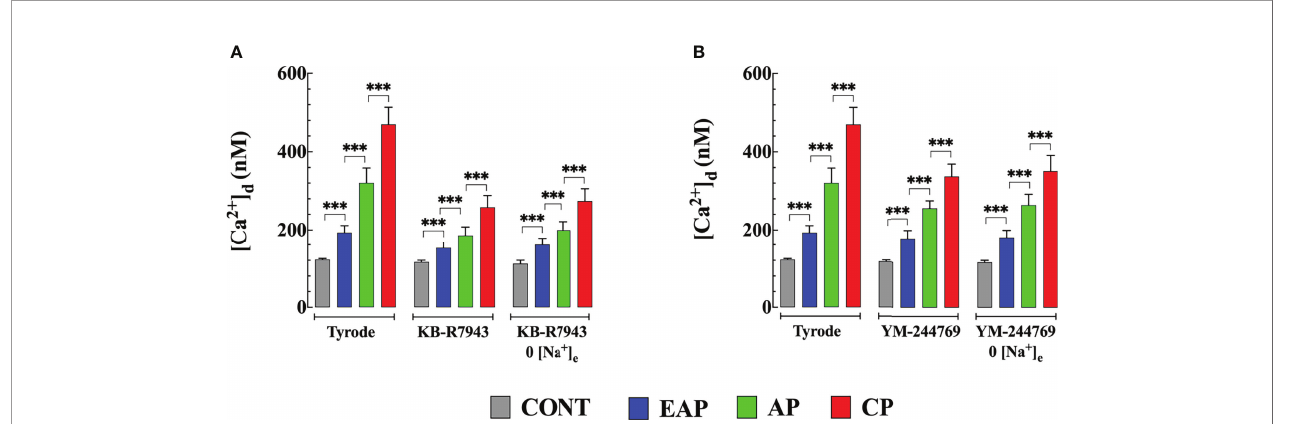
FIGURE 5 | NCX blockers inhibited Na + withdraw-induced [Ca 2+ ] d increases in cardiomyocytes from control and Chagas infected mice. (A) Effects of KB-R7943 and (B) YM-244769 on [Ca 2+ ] d increases caused by Na + removal. [Ca 2+ ] d was determined in (i) normal Tyrode solution (ii) after 10 min of incubation with 10 m m KB- R7943) or 1 µM YM-244769 and (iii) after incubation, either KB-R7943 in Na + free solution or YM-244769 in Na + free solution. Experiments were carried out in cardiomyocytes from CONT (n cells =15-24 and n mice =6), EAP (n cells =12-19 and n mice =8), AP (n cells =13-21 and n mice =8) and CP cardiomyocytes (n cells =11-18 and n mice =9). Data are expressed as mean ± S.E. Statistical analysis was performed as described above, ***p < 0.001. CONT: control mice; EAP: early acute phase of infected mice; AP: acute phase of infected mice; and CP: chronic phase of infected